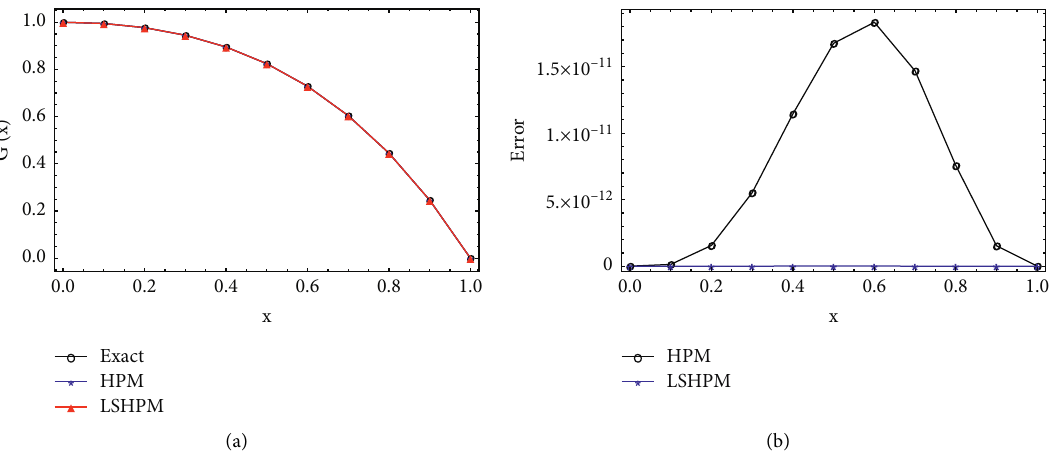
Figure 11: Graphical representation of solutions and errors in Problem 11. (a) Comparison of Exact, HPM, and LSHPM solutions. (b) Comparison of absolute errors of HPM and LSHPM.